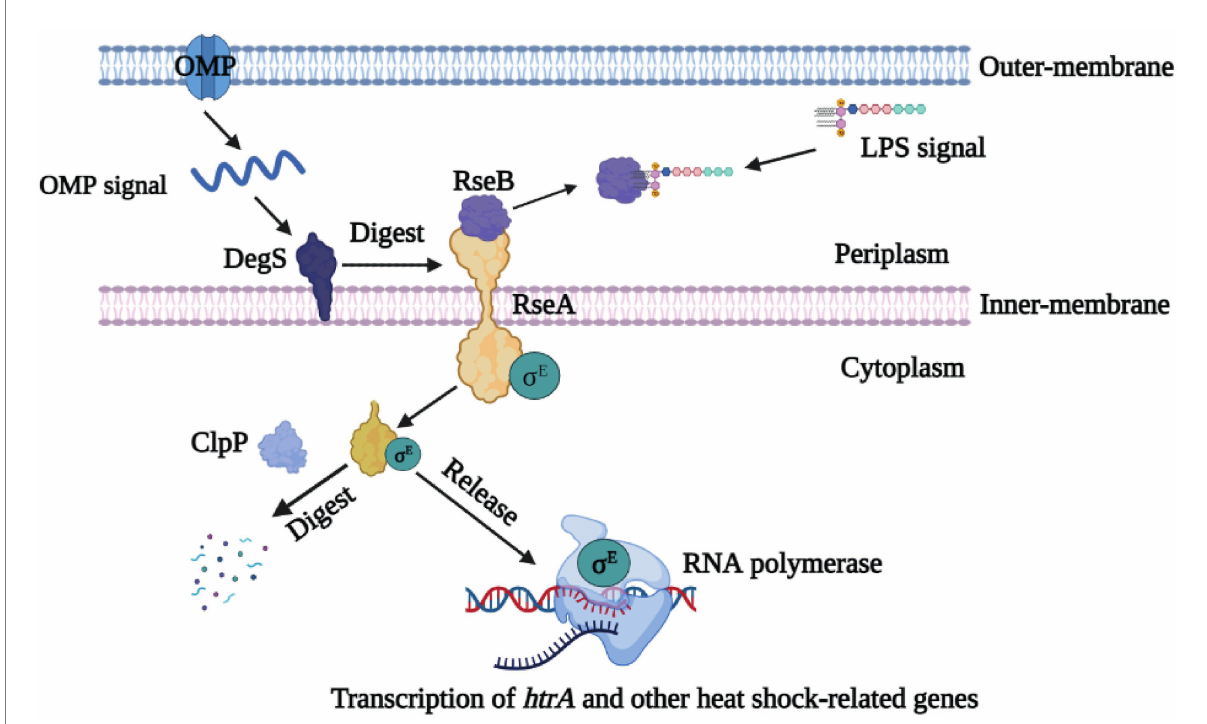
FIGURE 6 Schematic drawing of the σ E signaling pathway. As stress sensor proteins, DegS protease is activated by the binding of the OMP C-terminus, and RseB is relieved from RseA by the accumulation of LPS in the periplasm. RseA is sequentially digested by DegS and ClpP, thereby releasing σ E in the cytoplasm. Finally, σ E along with RNA polymerase can induce the transcription of the htrA gene and other heat shock- relate